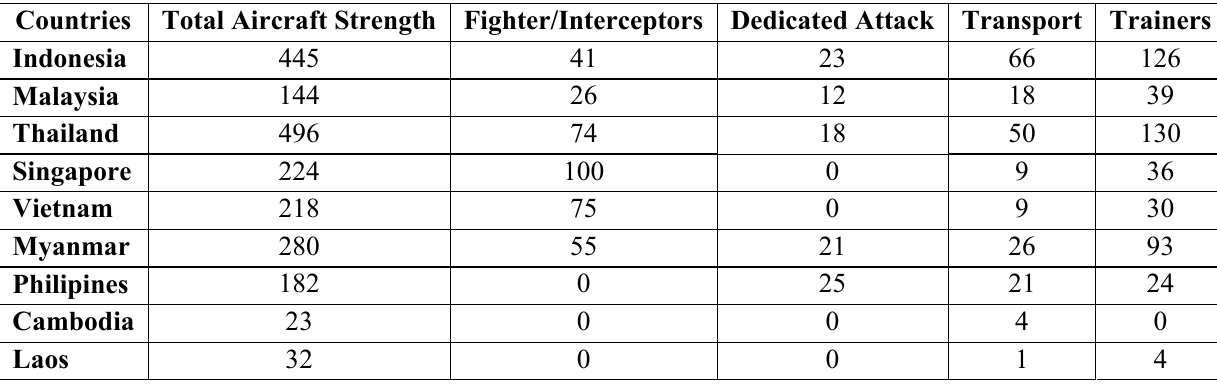
Table 1. Air Force comparison of several ASEAN (Source: GFP Index, 2022; processed